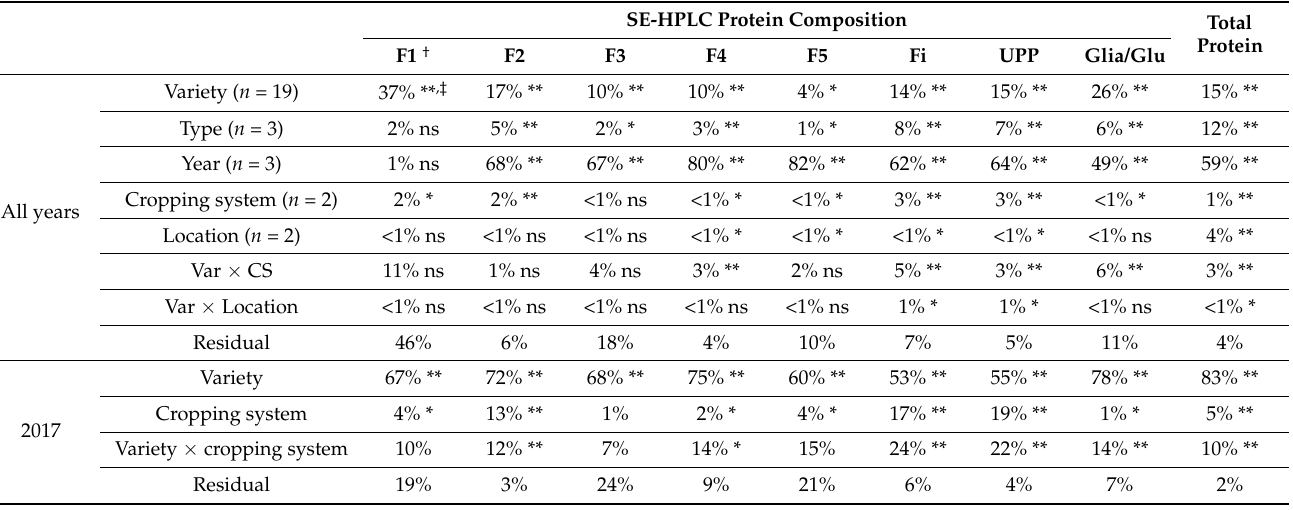
Figure 1. Yield (t. ha − 1 ) vs. Protein content (% db NIRS) in the 5 environments. FAR: varieties used by the farmer’ pasta makers; IND: varieties recommended by the industry; DIV: underutilized genetic resources. Table 4. Contribution of each factor (Variety, Type, Year, Cropping system, and Location) to the variability of parameters concerning protein composition determined by SE-HPLC. Variance per- centages coming from ANOVAs on lab-milled grains from the 2017 harvest (Sum of squares of each factor/total sum of squares) for each of the protein